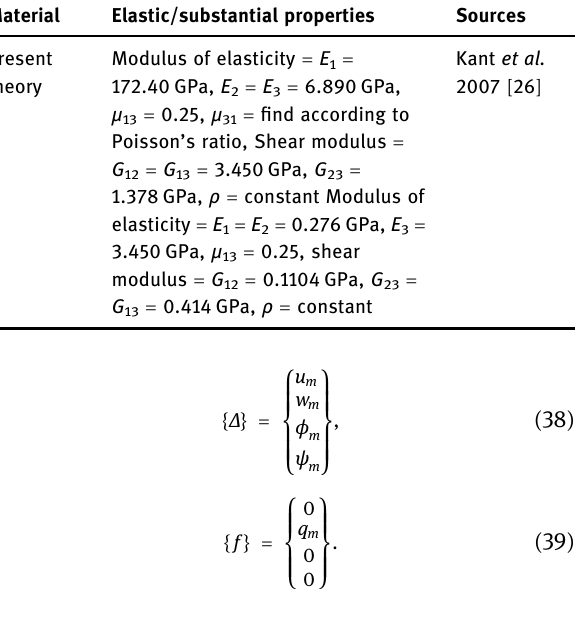
Table 2: Material properties of antisymmetric two - layered, sym - metric three - layered composite, and sandwich arches